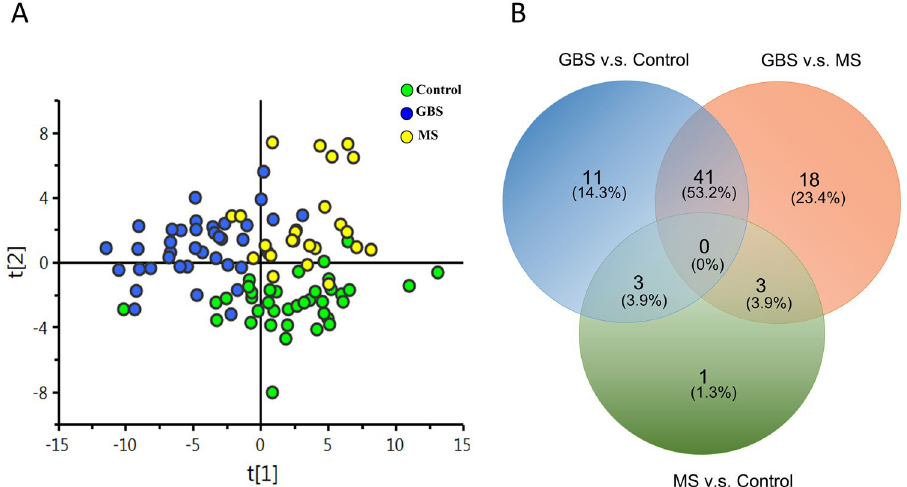
Figure 1. Targeted metabolomics profiles in the GBS patients, the multiple sclerosis (MS) patients, and the healthy controls (control). Extracted plasma from GBS patients (n = 38), MS patients (n = 22) and healthy controls (n = 40) were analyzed by LC-MS/MS and FIA-MS/MS in electrospray positive and negative ion mode. ( A ) The orthogonal partial least squares discriminant analysis (OPLS-DA) demonstrates a clear separation of metabolites between GBS, MS, and control cases (R2 = 0.503, Q2 = 0.338). ( B ) A Venn diagram was used to visualize the number of extremely different metabolites (p < 0.05) after one-way ANOVA analysis with Tukey’s post hoc test with false discovery rate (FDR) correction between the GBS and MS patients and the